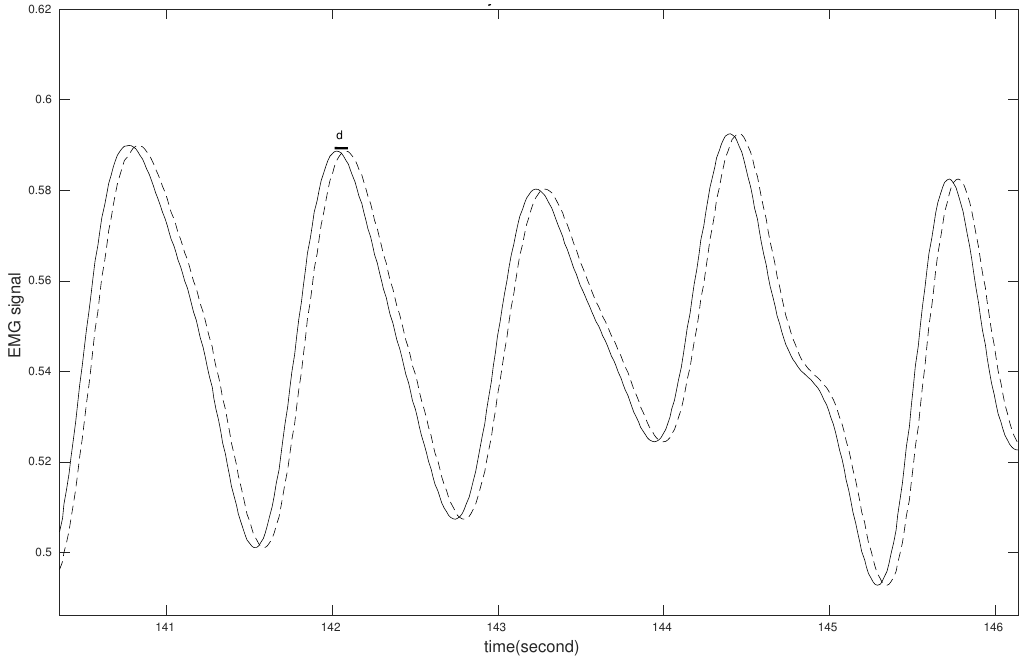
Figure 4. Similar to Figure 3 but for two other muscles under consideration. Figure panels correspondence as in Figure 3. Block ( a ) for left tibialis anterior (LTA); block ( b ) for left gastrocnemius (LGT).